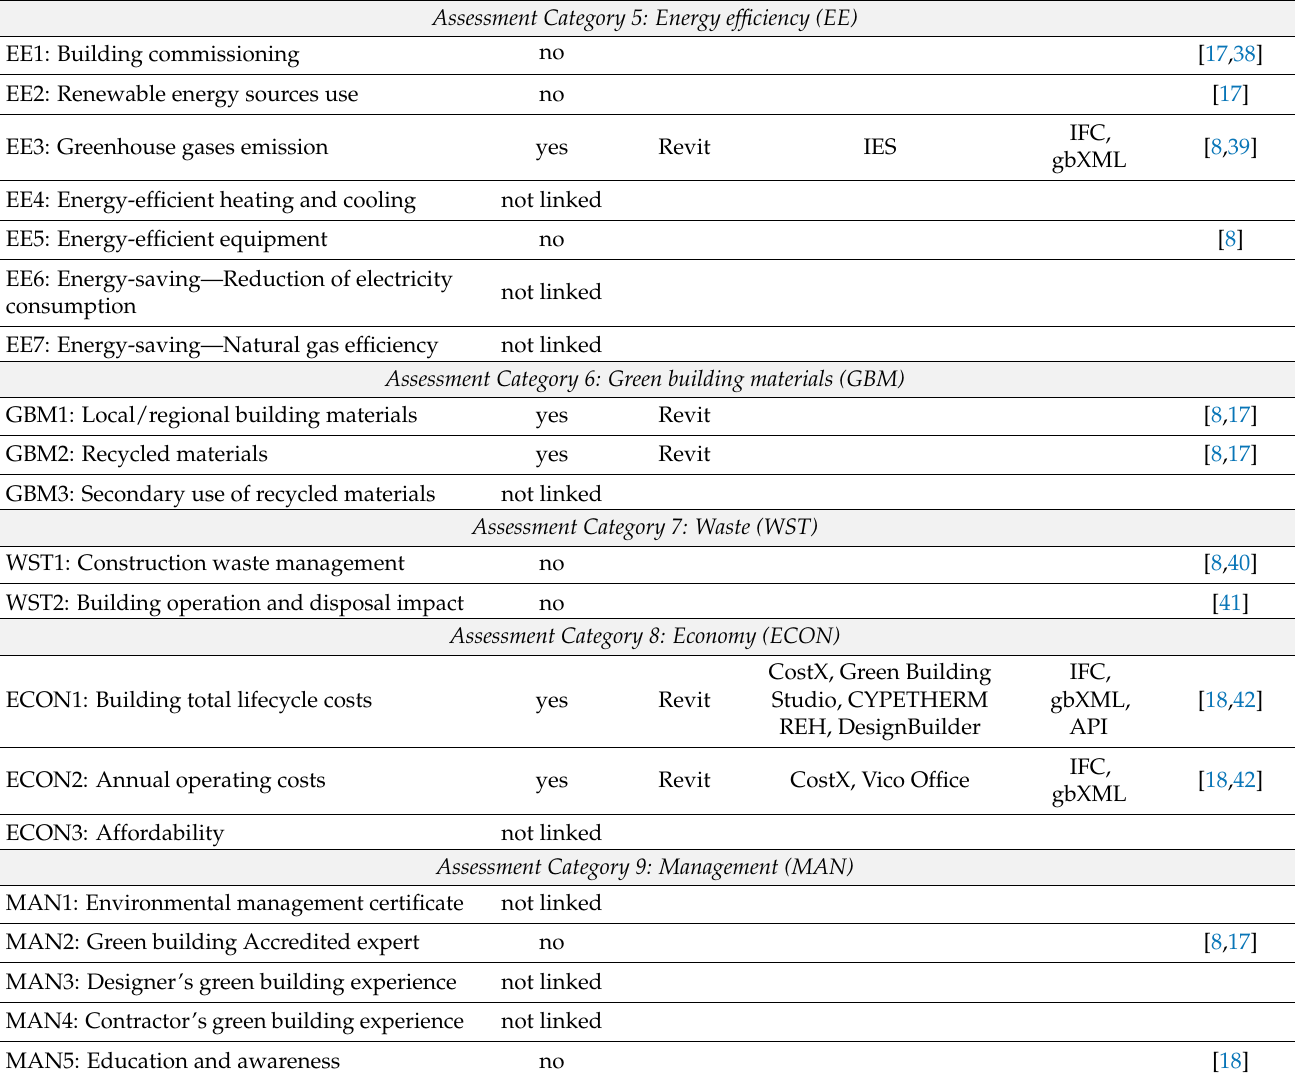
Table 2. Cont. Assessment Category 5: Energy efficiency